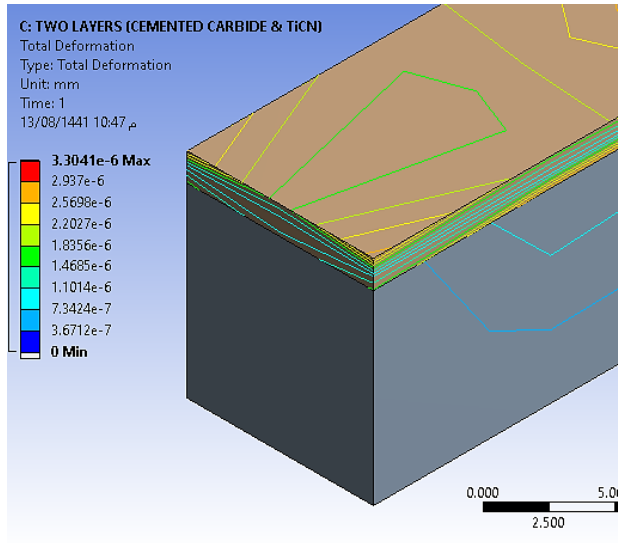
Fig. 19. Graph of total deformation normal force on the TiCN surface, 250 N load without thermal condition